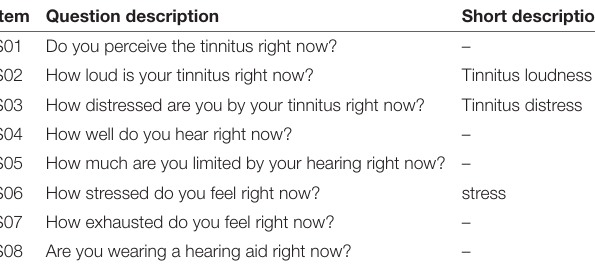
TABLE 1 | Items S01 to S08 from the EMA questionnaire of TinnitusTipps—the range of values for the answers of the items S02-S07 is between 0 and 100 (first two columns shown also in Shahania et al.,